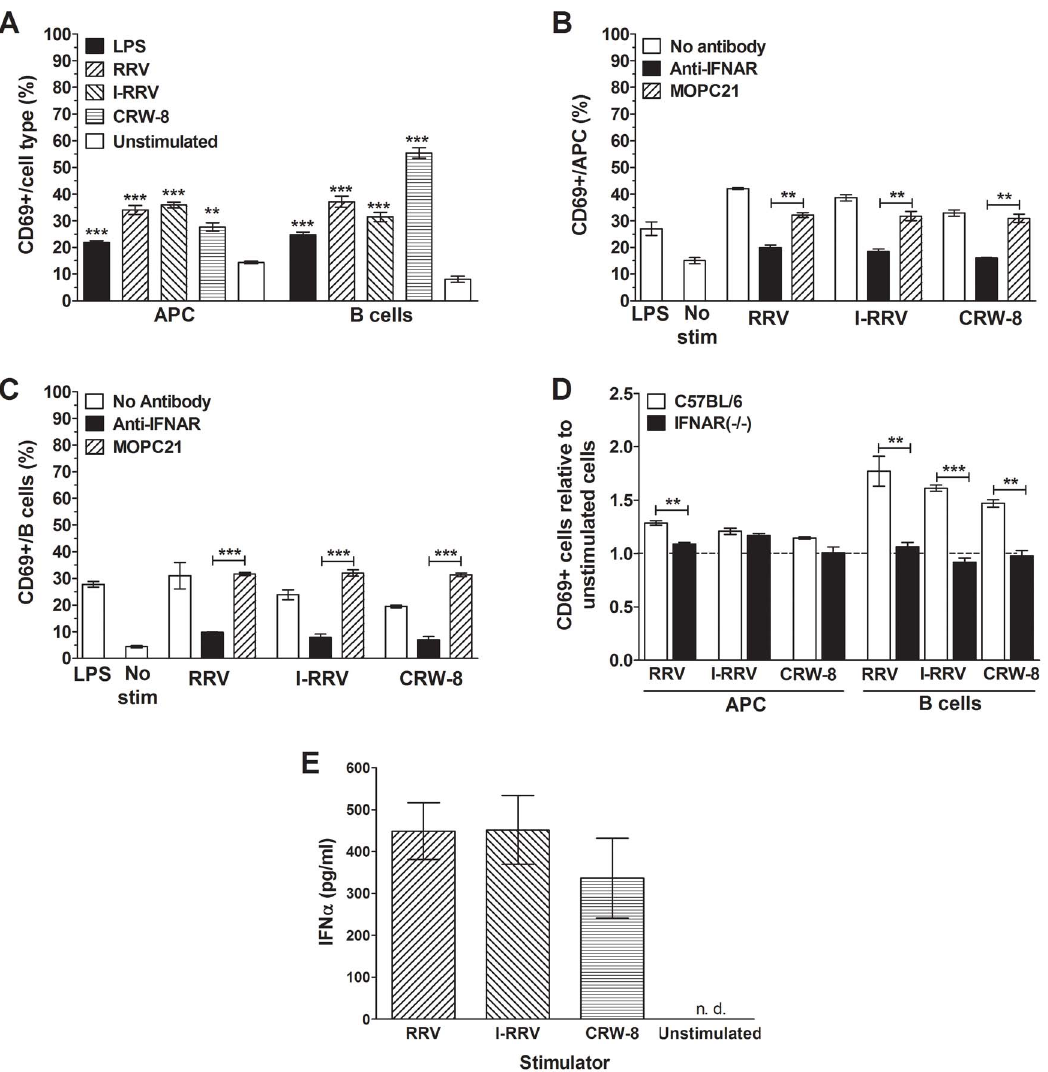
Figure 5. Analysis of the role of a soluble factor signaling through the IFNAR, particularly IFN a , in APC and B cell activation by rotavirus. (A) CD69 expression by APCs and B cells in NOD mouse splenocyte cultures that had been stimulated for 24 h with 150 m l of supernatant fluid collected from the experiments described in Figure 2C, together with 50 m l of RF 10 medium. CD69 expression by APCs (B) and B cells (C) in NOD mouse splenocyte cultures treated with anti-IFNAR or isotype control antibody MOPC21 for 30 min 4 u C prior to rotavirus stimulation for 24 h. Cells also were stimulated with 100 ng/ml LPS as a positive control. In (B) and (C) control cultures were unstimulated (No stim). (D) Proportions of APCs and B cells expressing CD69 in cultures of splenocytes isolated from female C57BL/6 or IFNAR (-/-) mice, after rotavirus stimulation for 24 h. Cell proportions were expressed as a ratio to unstimulated controls. (E) IFN a levels in supernatant fluids from unsorted NOD splenocytes cultured with rotavirus or left unstimulated for 24 h. Data in A to C are derived from one experiment and are representative of two independent experiments. Data in D were derived from a single experiment. Error bars in A to D indicate the mean 6 SEM of 3 replicates. Data in E represent the mean 6 SEM of 3 independent experiments. ** p , 0.01 and *** p , 0.001 compared with the respective control. n.d.= not